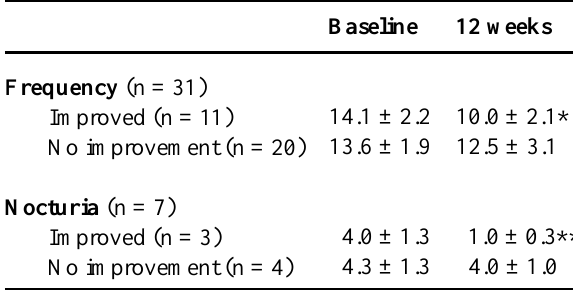
Table 1 – Bladder diary of patients who did or did not improve in frequency and nocturia